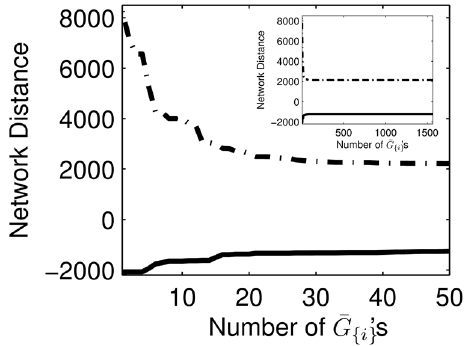
Figure 7. Ensemble inference of E.coli GRN from error-free (cid:2) GG 6 0 and the complete set of (cid:2) GG f i g ’s. The plot shows the network distances of the lower and upper bounds from G 6 0 as a function of the number of (cid:2) GG f i g ’s for the 50 most informative (cid:2) GG f i g ’s, i.e. the top 50 highest number of testable edges. The incorporation of (cid:2) GG f i g ’s and G was performed sequentially in decreasing number of testable edges. The inset shows the result for the complete set of (cid:2) GG f i g ’s.